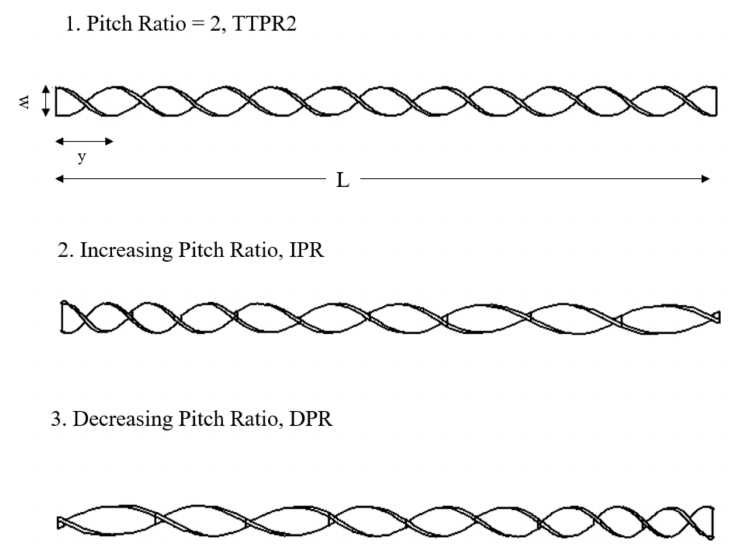
Figure 1. Geometries of the twisted